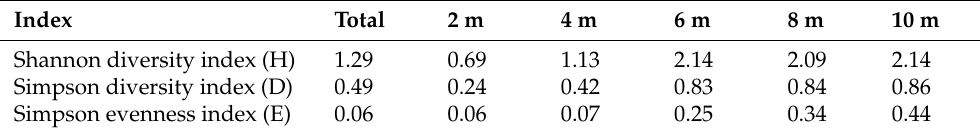
Table 5. Diversity and uniformity of the fouling community on larval collectors in Javorike Cove in 2020.